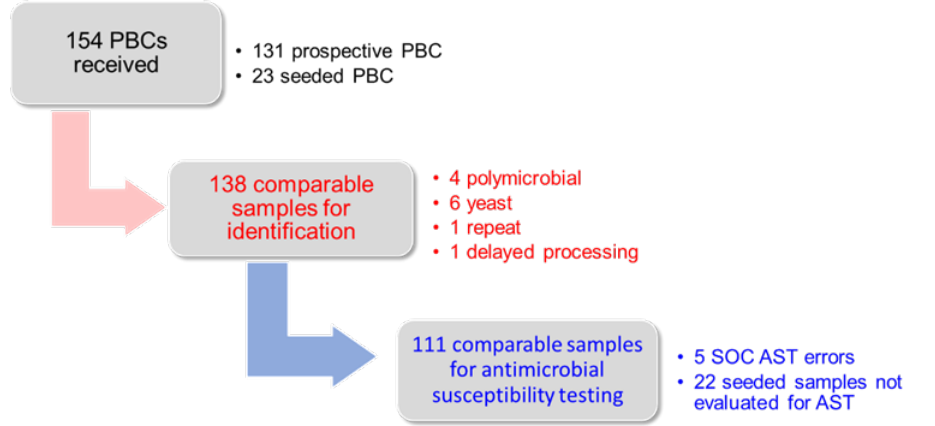
Figure 1. Study summary. During the study period, 131 positive blood cultures (PBCs) were re- ceived and 23 blood cultures were seeded with known organisms. Some samples were excluded for the reasons shown, leaving 138 samples for ID comparison and 111 samples for AST